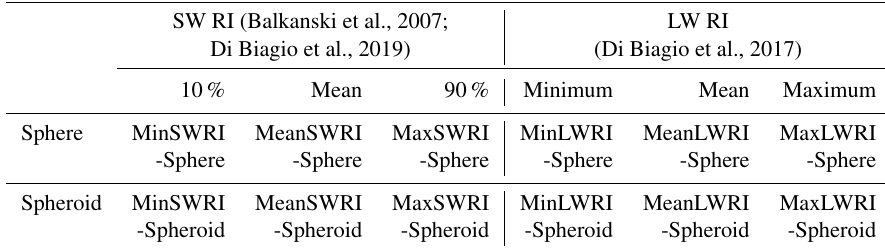
Table 1. Dust models used in this study. Three dust RI are used in shortwave (SW) and longwave (LW) to represent less, mean, and more absorptive dust. Two dust shape models are used to represent spherical and spheroidal dust shape. The three dust RI sets and two dust shapes constitute six dust models in each of SW and LW. SW RI (Balkanski et al., 2007; LW RI Di Biagio et al., 2019) (Di Biagio et al., 2017) 10% Mean 90% Mean MinSWRI MeanSWRI MaxLWRI -Sphere -Sphere -Sphere -Sphere